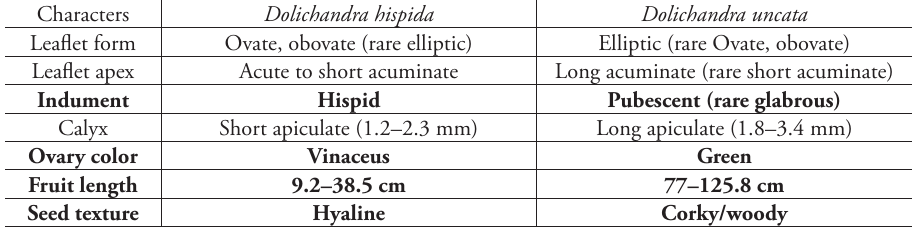
Table 1. Comparison of Dolichandra hispida and D. uncata ; non-overlapping characters are shown in bold.